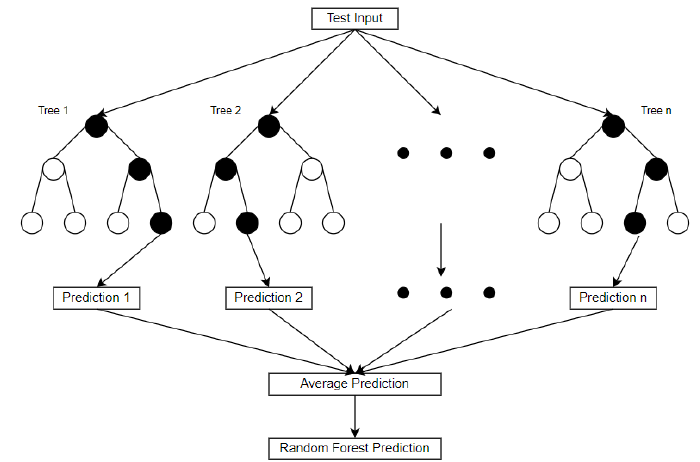
Figure 3. Structure of neural network model.